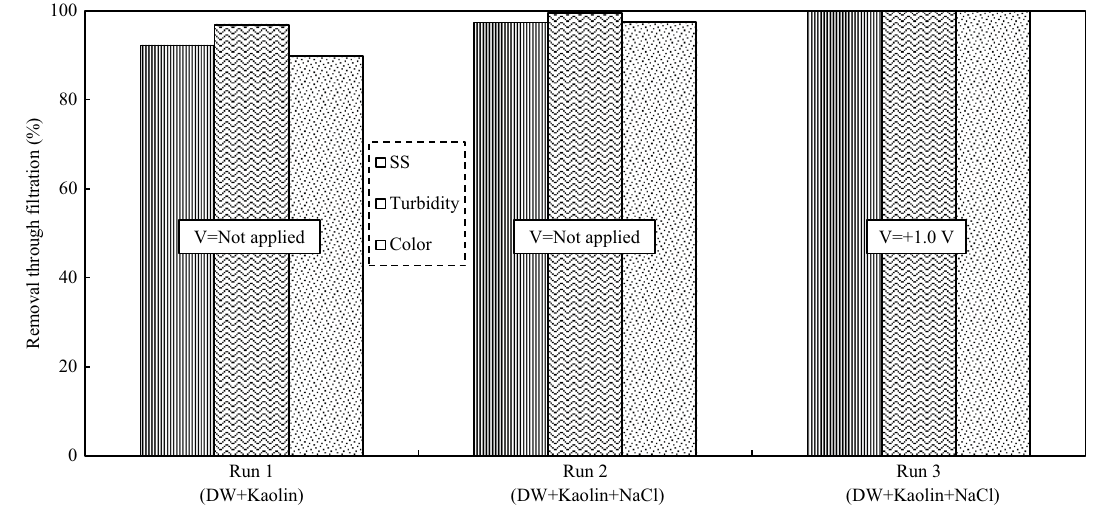
Fig. 5 SS, turbidity, and color removal efficiency of Runs 1–3 at the filtration hydraulic loading of 283 L/m 2 /min, without application of terminal voltage in Runs 1 and 2, and + 1.0 V terminal voltage was applied in Run